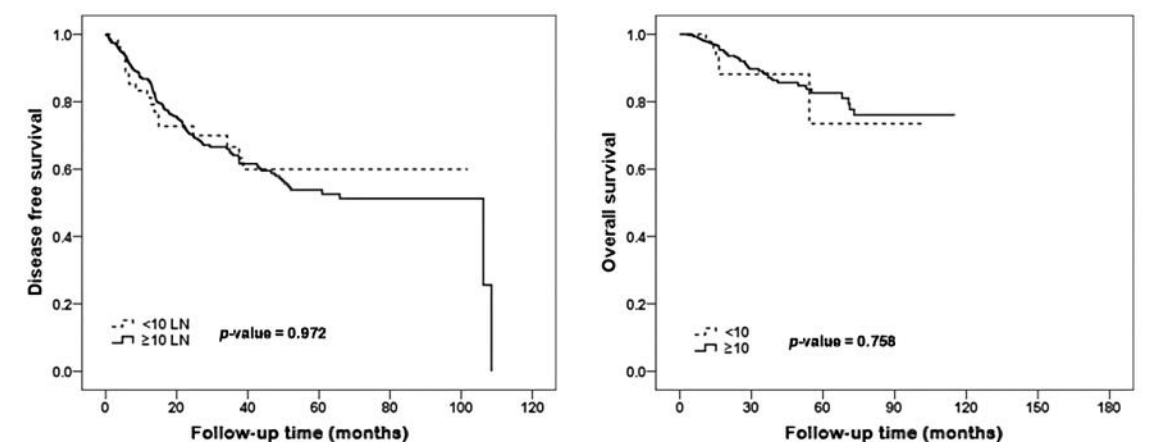
Figure 3. Kaplan – Meier survival curves for disease-free survival and overall survival in lymph node-positive patients according to lymph node number. Among the 285 ypN0 patients, the <10 nodes group included 69 patients and the ≥ 10 nodes group included 216 patients. There were 13 recurrences in the <10 lymph nodes group, of which 5 had local recurrence, 26 had recurrence in the ≥ 10 lymph nodes group, and 7 had local recurrence. Table 2 shows the characteristics of the pathologic node-negative ALND group according to removed lymph node number. The ypN0 group with <10 nodes had no significantly different characteristics compared with the